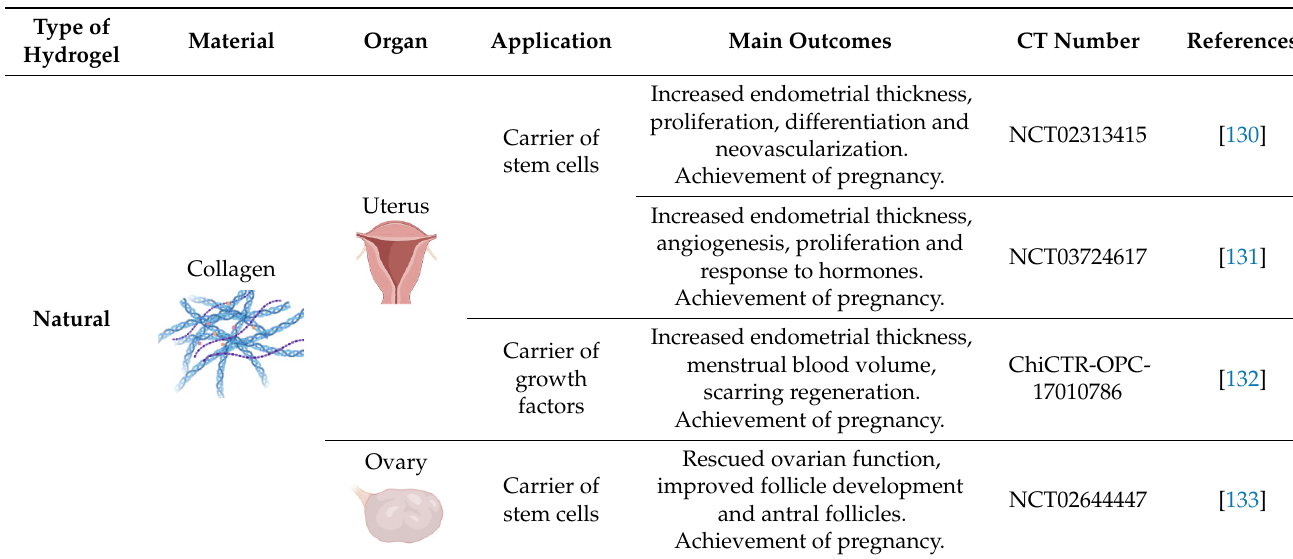
Table 2. Non-ECM hydrogel application in human clinical trials.